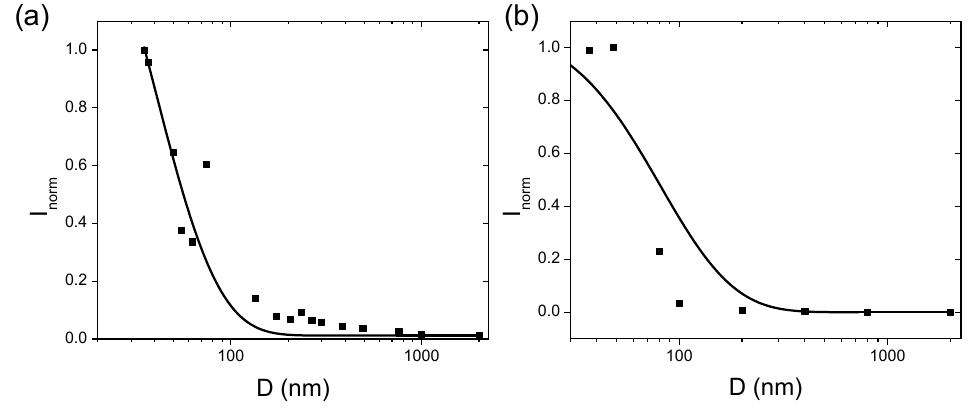
Figure 2. The comparison of the intensity model (solid lines) described by Equations (9) and (10) with experimental measurements (dots) for two samples. Both samples consist of a single InGaN quantum disk region in the nanopillar. The indium compositions are different in the two samples: In 0.15 Ga 0.85 N 3.5 nm and In 0.32 Ga 0.68 N 2.5 nm. 1/ κ ’s were previously obtained to be 14 nm and 31 nm for samples ( a , b ), respectively by fitting the emission wavelength data to Equation (4) [21]. The measured optical intensity (power received by the detector/quantum disk area) was normalized with respect to the value of the smallest nanopillar. One fitting parameter B 1 was used. B 1 = 3.528 and 0.6346 in ( a , b ),